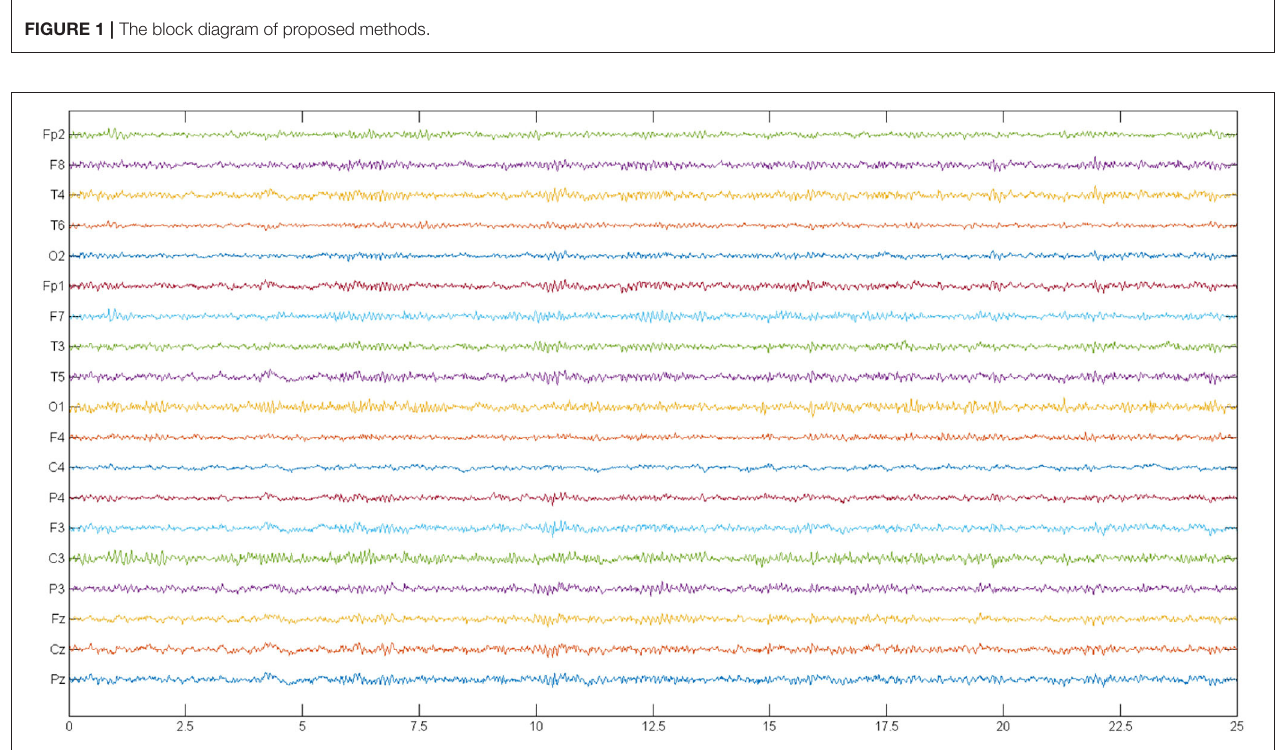
FIGURE 2 | A sample frame of the EEG signals of a person with SZ. EEG, electroencephalograph; SZ,